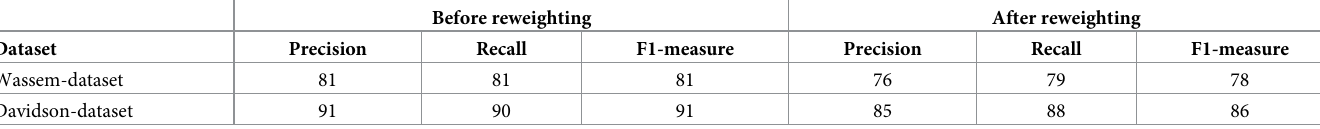
After reweighting Precision Recall